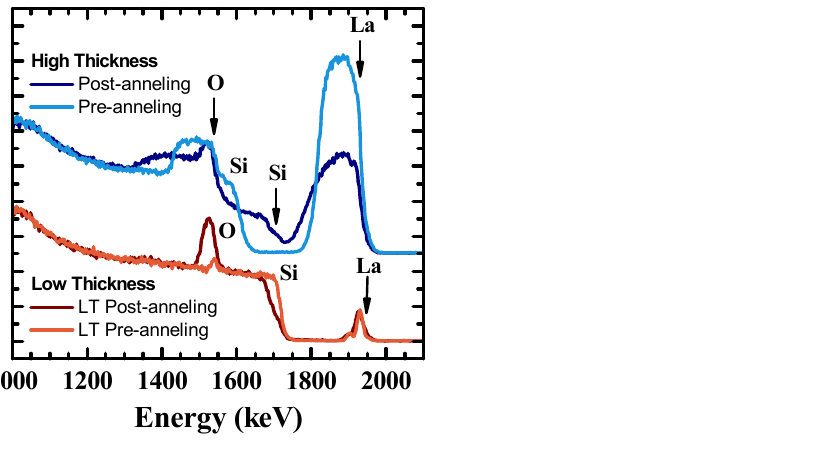
Figure 2. Comparison between pre/post-annealing and high/low-thicknesses Rutherford backscattering spectroscopy spectra of Nd-doped lanthanum niobate sputtered thin films. For the post-annealed sample with high thickness, the Si edge placed at the 1725 keV channel originates from the Si taking part of the mixed top later, showing its concentration depth profile, whereas the Si edge at the lower-energy 1625 keV channel is associated with the Si substrate.